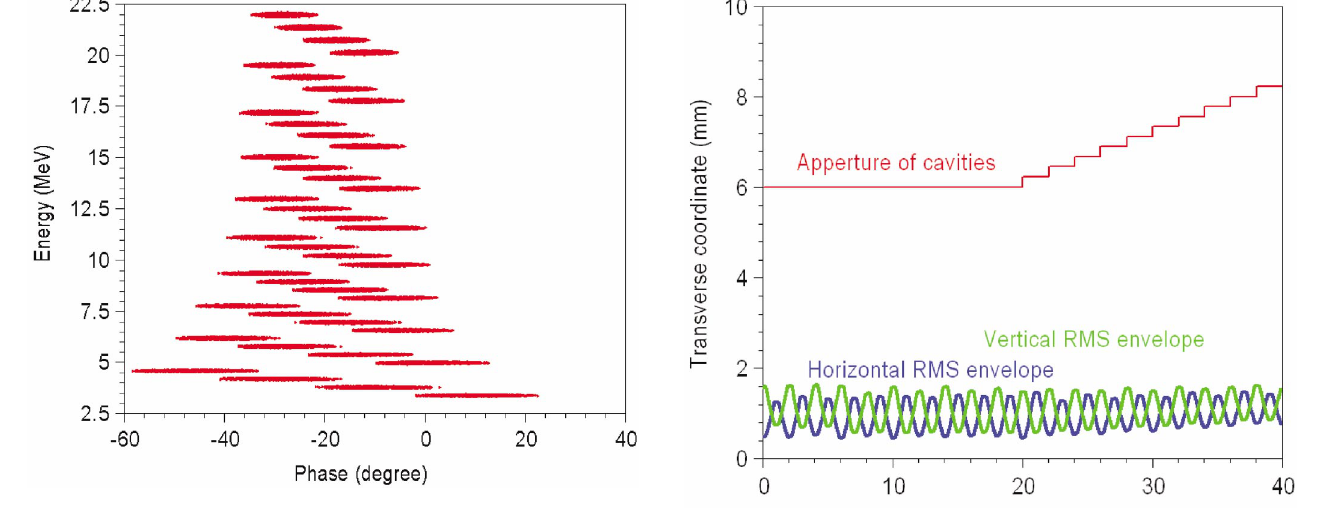
FIG. 26. (Color) Bunch propagation through the linac.